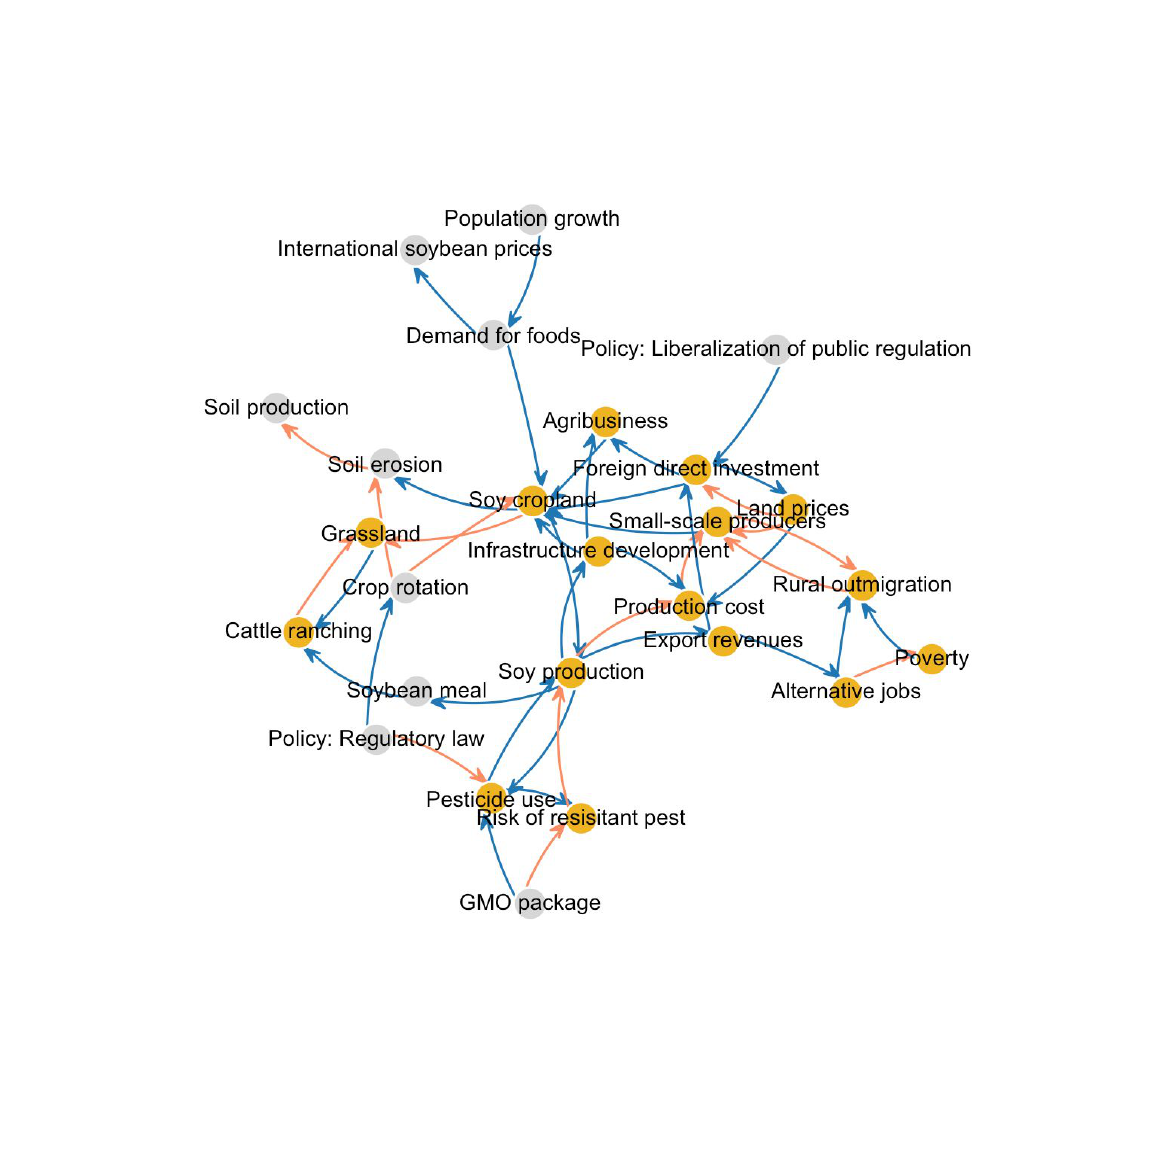
Figure A1.6. CLD Soybean agribusiness expansion in the Litoral region, ​​